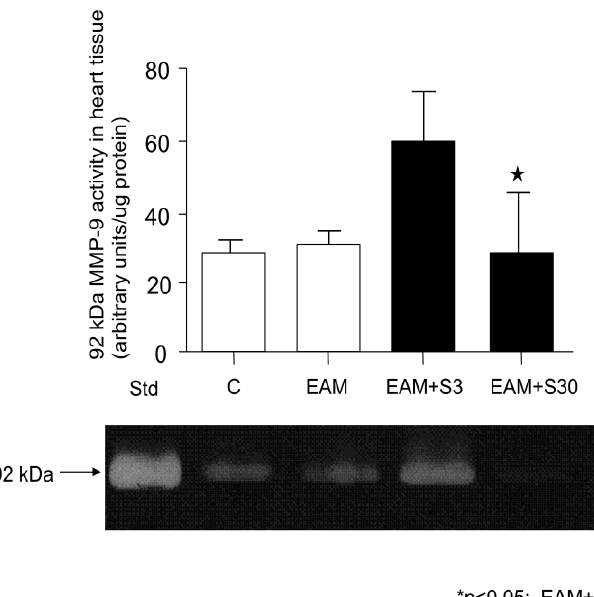
Figure 2. 92-kDa MMP-9 activities in heart tissue and representative zymogram showing gelatinolytic activities in heart tissue. C indicates not immunized group without simvastatin; EAM—group with induced EAM without simvastatin; EAM+S3—low-dosage simvastatin EAM group (3 mg/kg/d); EAM+S30—high-dosage simvastatin EAM group (30 mg/kg/d); 92 kDa indicates matrix metalloproteinase 9.